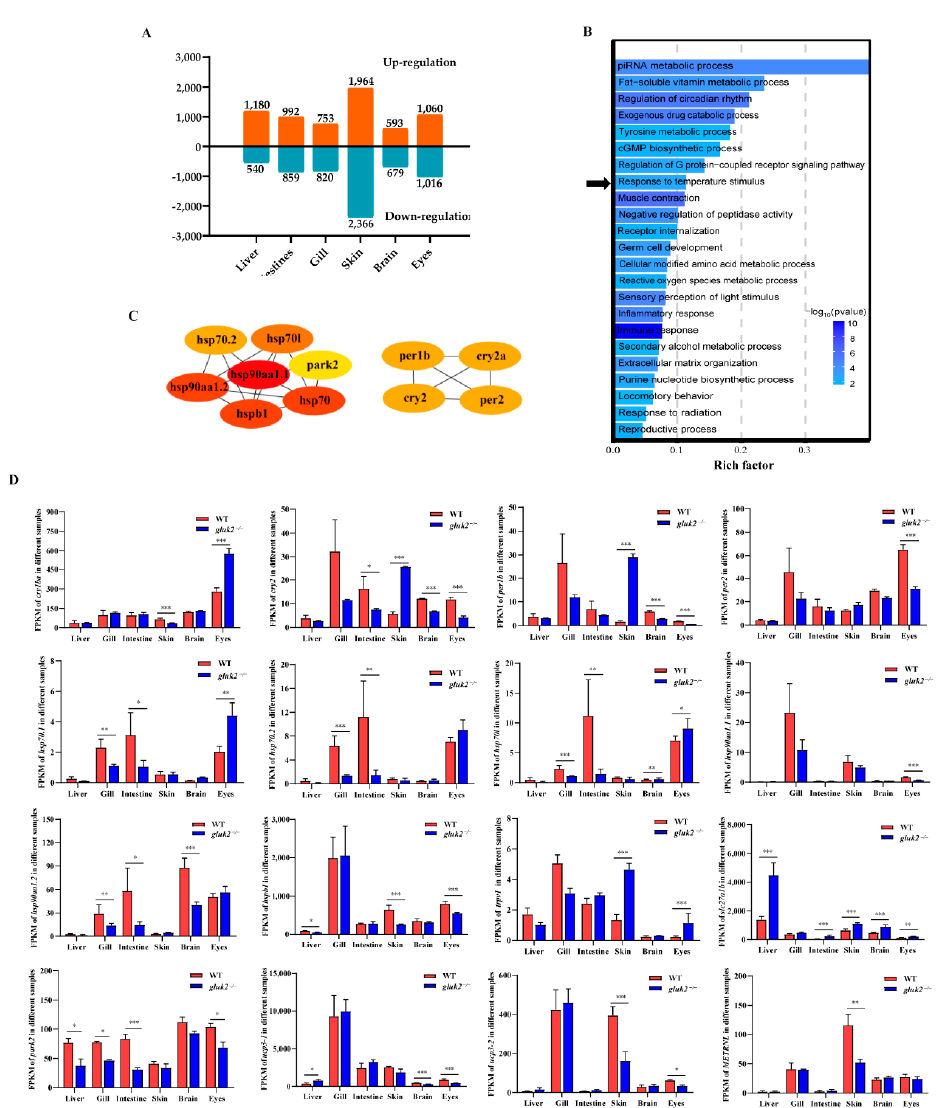
Figure 2. Divergent pathway and gene expression between wild-type and gluk2 − / − mutant. ( A ) Number of DEGs obtained from the six tissues at the wild-type and gluk2 − / − mutant. ( B ) Gene Ontology (GO) enrichment analysis of differentially expressed genes identified from the wild-type and gluk2 − / − mutant. The abscissa represents the GO terms, and the ordinate represents the number of target genes. Black arrow indicates the ‘Response to temperature stimulus’ pathway. ( C ) Protein–protein interaction network for gluk2 − / − expressed in the response to temperature stimulus pathway. ( D ) Fragments Per Kilobase per Million (FPKM) of divergent gene expression related to temperature signaling pathway in different tissues. Values plotted are means ± SEM, * p < 0.05, ** p < 0.01, *** p < 0.001, compared with control.